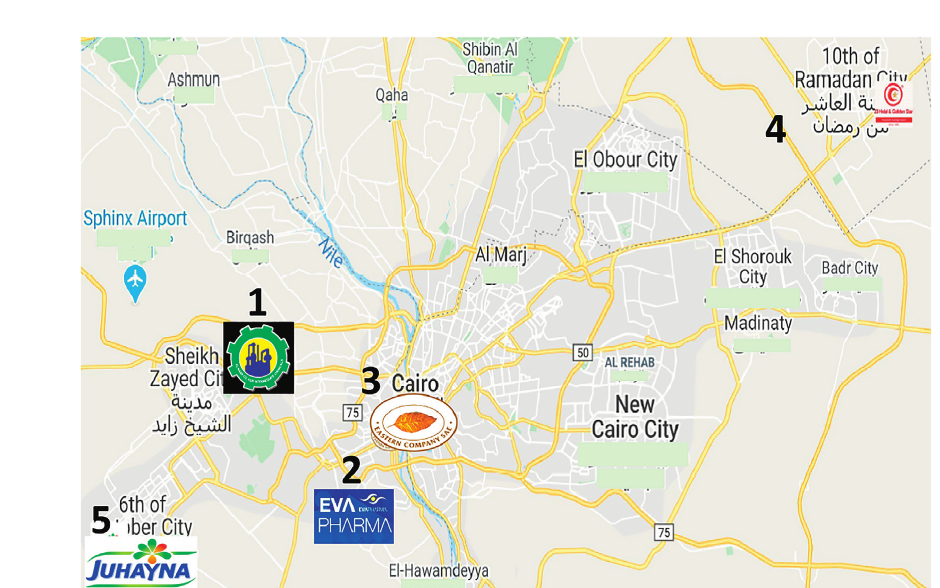
Figure 2: Location of the candidate workplaces.